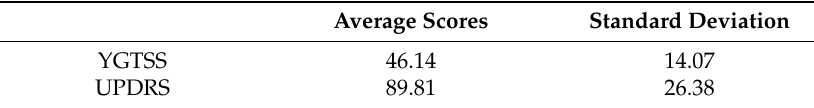
Table 5. Average YGTSS and UPDRS scores of the